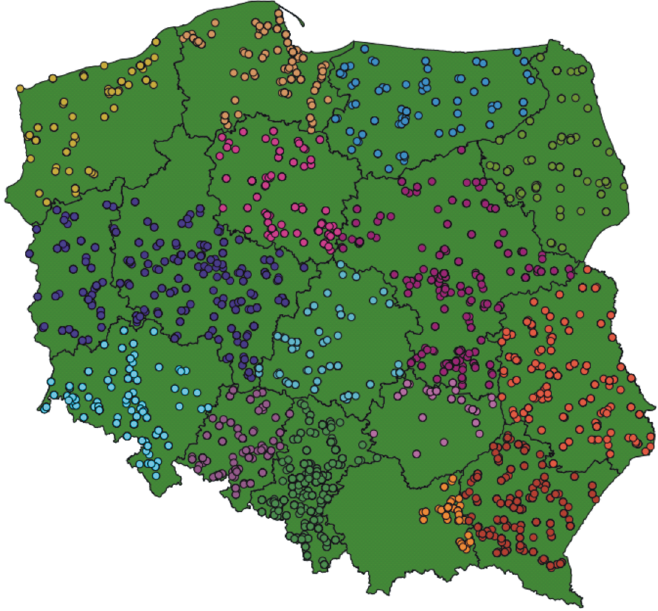
Fig 1. Geographic residence place of recruited participants included in study